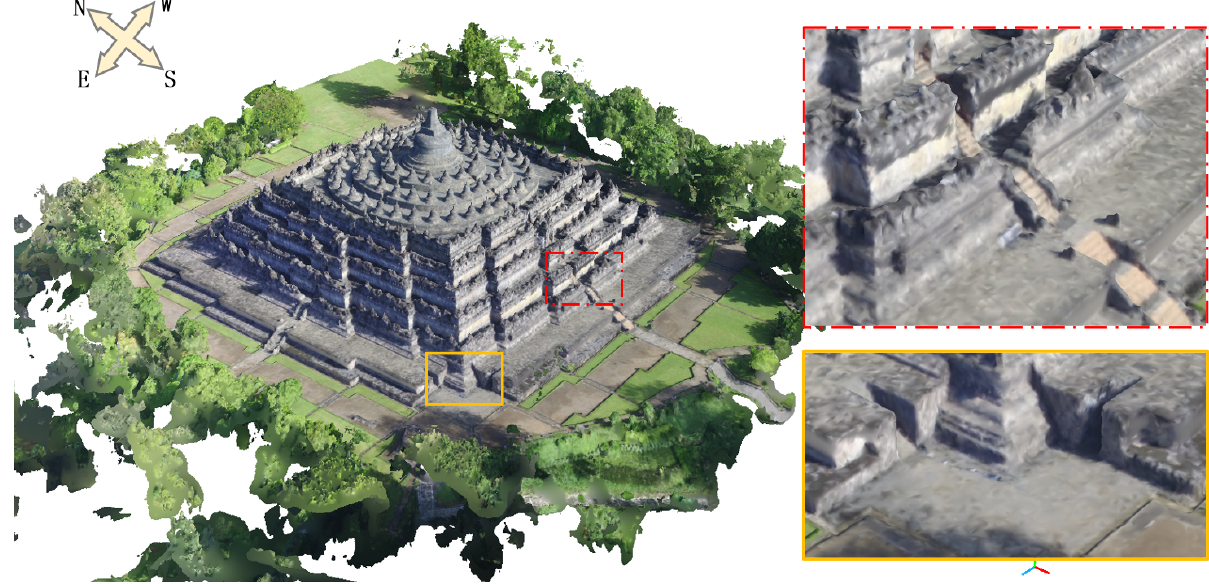
Figure 11. Remote scanned points of the Borobudur